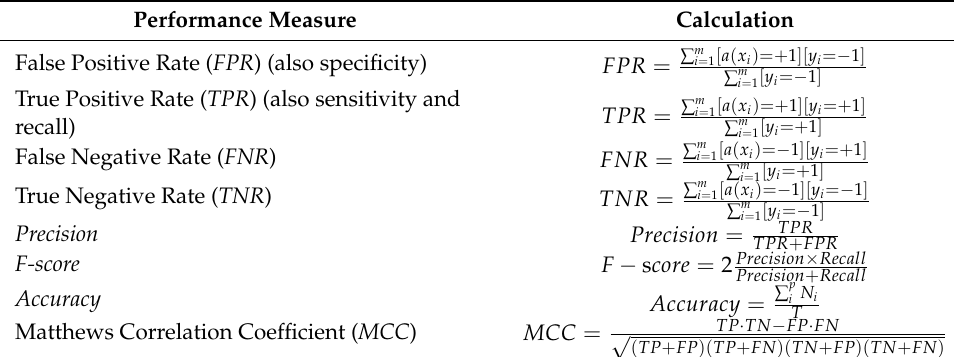
Table 2. Summary of performance measures calculated using true positive ( TP ), false positive ( FP ), true negative ( TN ), and false-negative ( FN ) values.